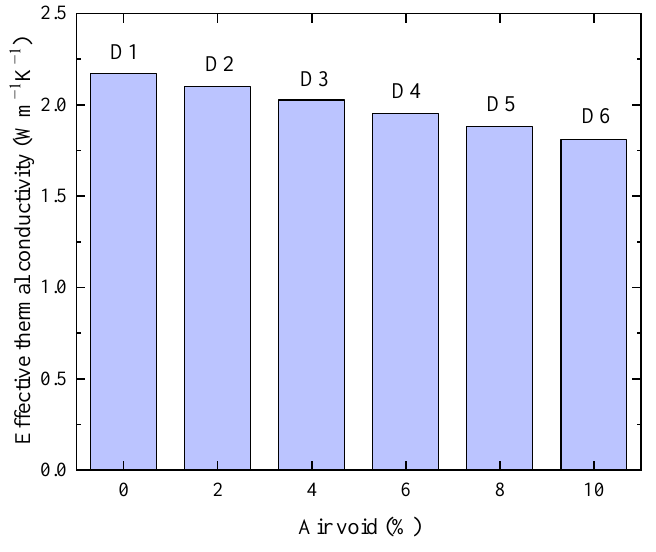
Figure 12. Effect of air void. To study the distribution nonuniformity of air voids, three groups of cube asphalt concrete specimens were generated, which were noted as E1~E3, respectively. The air voids in specimen E1 were uniformly distributed, and the air voids in specimen E2 and E3 were evenly distributed across the 15% of the total volume of the specimens, as shown in the gray shaded part in Figure 13. All other variables, except the spatial distribution of air voids, were consistent with the stochastic model D4.